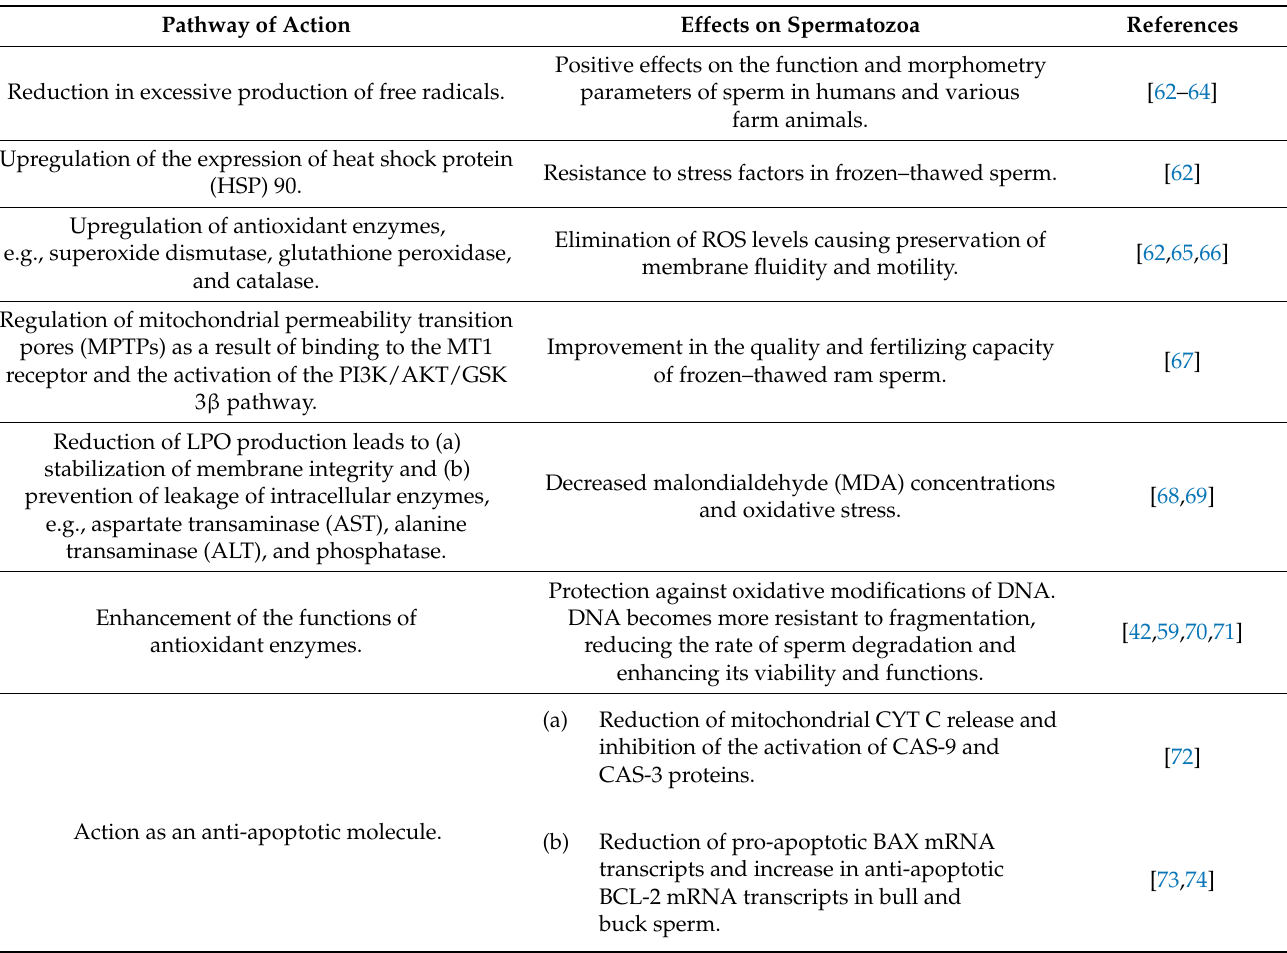
Table 1. Effects of melatonin on